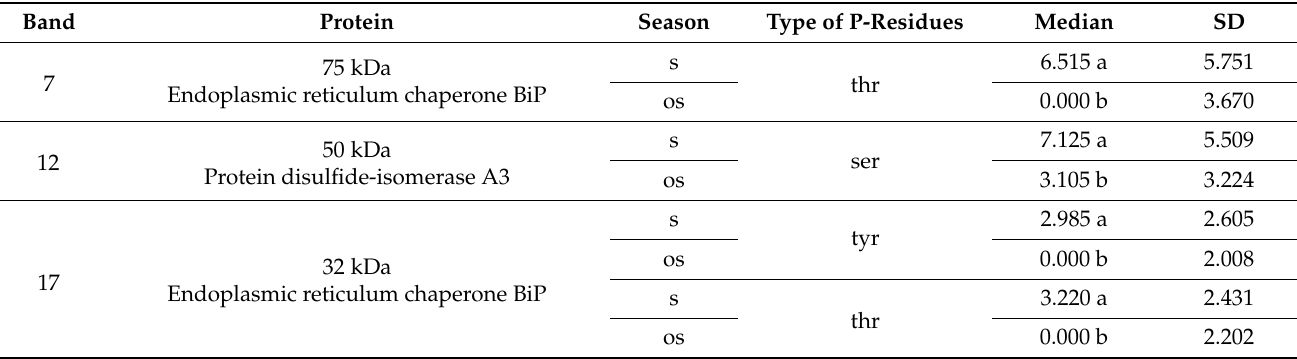
Table 2. Medians with standard deviations (SD) estimated for protein phosphorylation intensity (%) of every fraction (season × type of phosphorylated